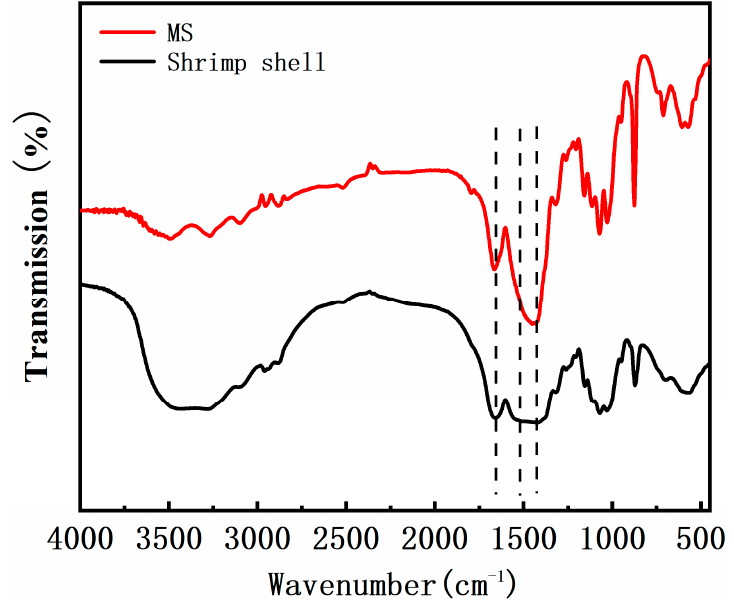
Figure 1. FTIR spectra of shrimp shell and MS.